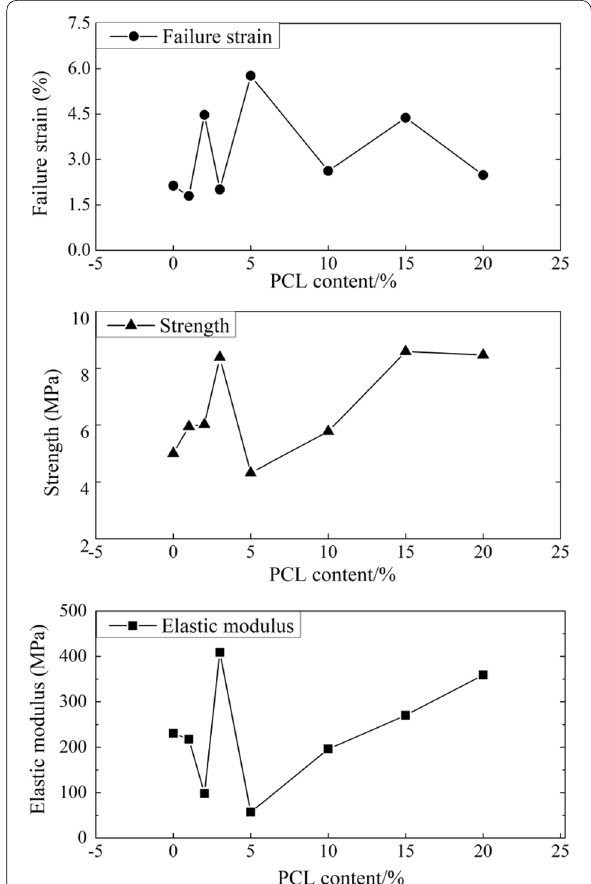
Fig. 18 Influence of PCL content on the mechanical parameters of cement